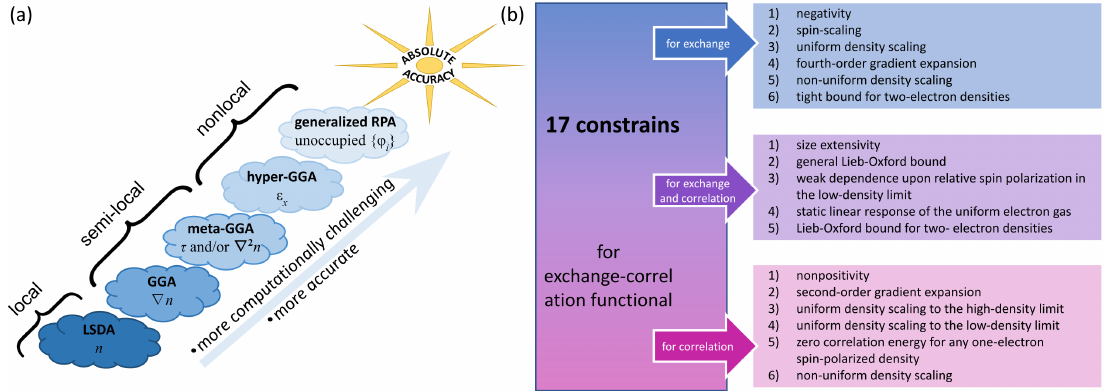
Figure 1. ( a ) Jacob’s ladder classifying the approximations for the exchange–correlation energy on the way to obtaining the absolute chemical accuracy. ( b ) Seventeen known exact constraints that a meta-GGA can fulfill [28–31]. Note, the SCAN functional obeys all of these